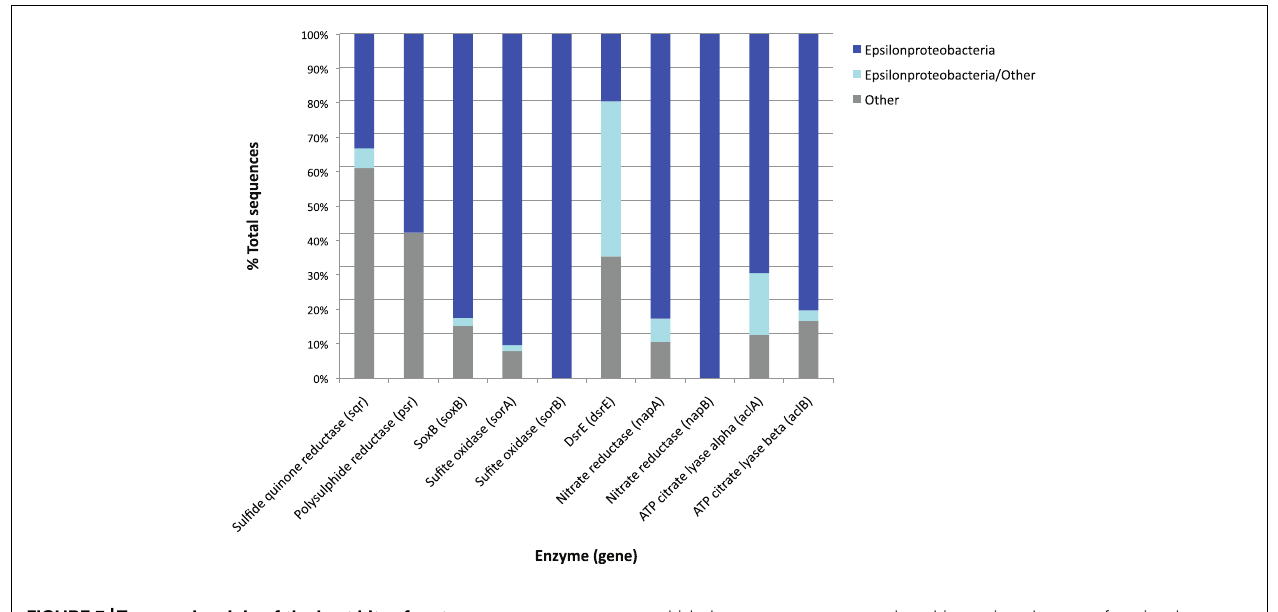
which there were two or more best hits against the same functional gene, but from different phyla.The taxonomic origin of these sequences cannot therefore be clearly determined.The “other” category includes all the other phyla represented within the best hits for each gene, and differ from gene to